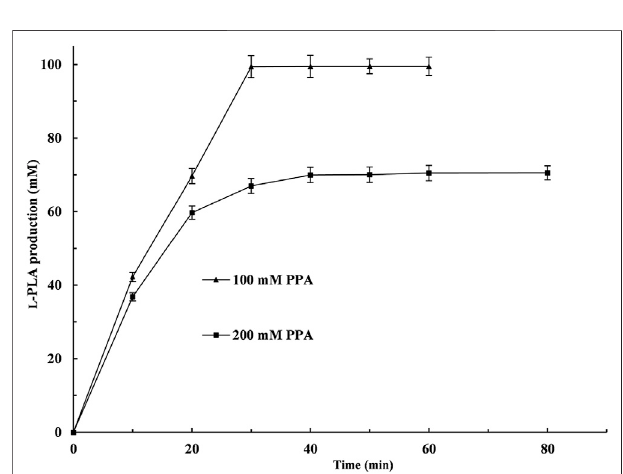
FIGURE. 6 | Time course of L-phenyllactic acid production from phenylpyruvic acid (PPA) by coupling L- Lc LDH1 Q88A/I229A (Pp) with Ls GDH D225C in vitro . ▲ , PPA concentration of 100 mM; ■ , PPA concentration of 200 mM. The bioconversion was conducted in 50 mM sodium acetate – acetate buffer (pH 5.0) containing 100 or 200 mM PPA and 120 mM glucose at 40 ° C within 80 min. Means and standard deviations of triplicate experiments are